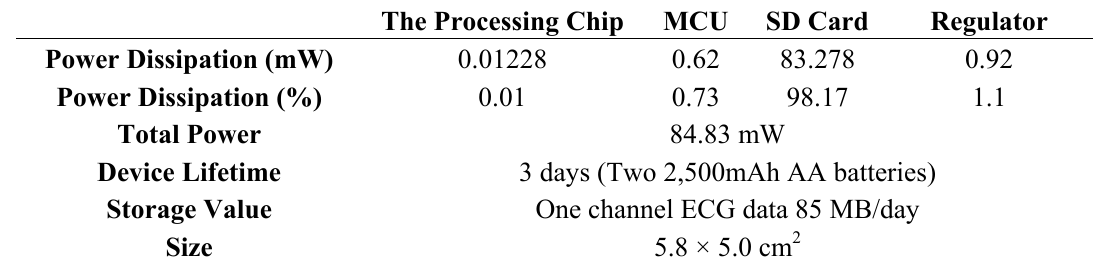
Table 3. Power consumption of the proposed acquisition device.